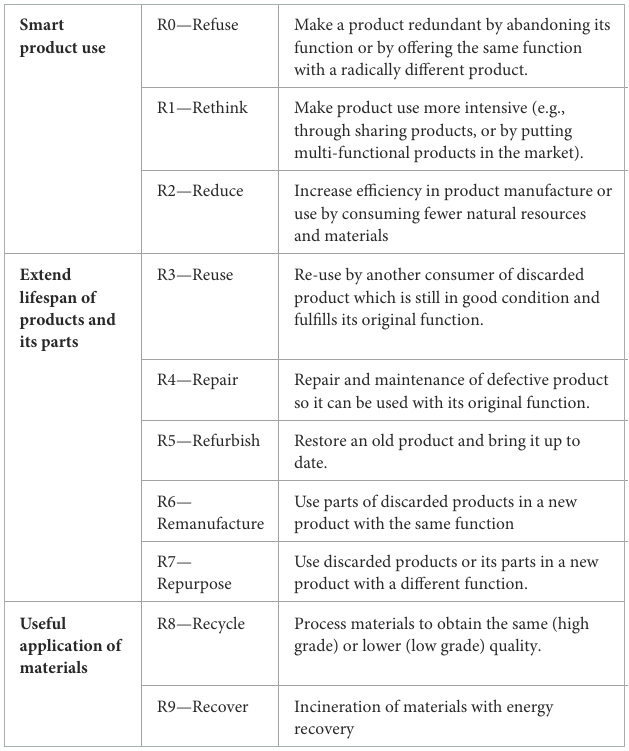
TABLE 1 A summarized explanation of 10 -R circular economy